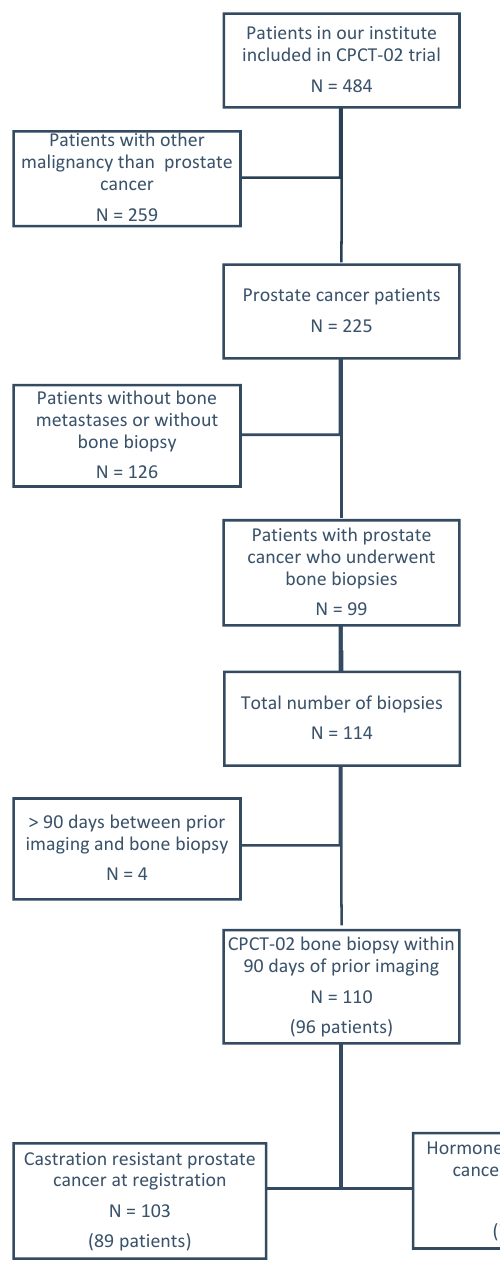
Figure 1. Flowchart. Figure 1.